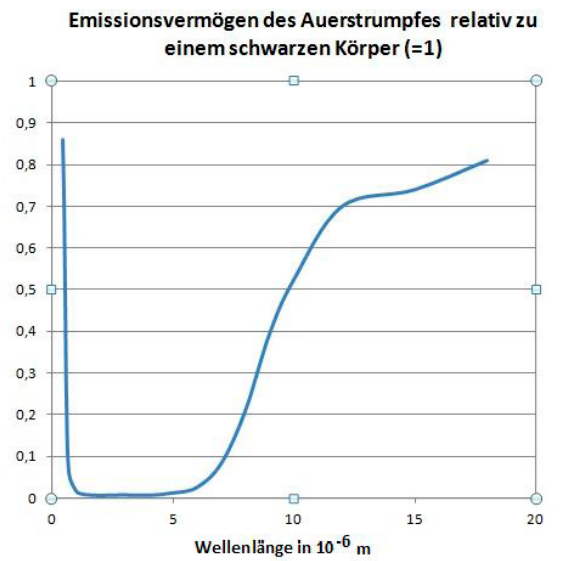
Figure 6. The emissivity of the Auer incandescent mantle relative to a black body (=1). Wellenlänge = wavelength 10 -6 m. Source: Rubens, Heinrich: “The emission spectrum of the Auer incandes- cent mantle”, in: Proceedings of the German Physical Society 7 (1905), Table,